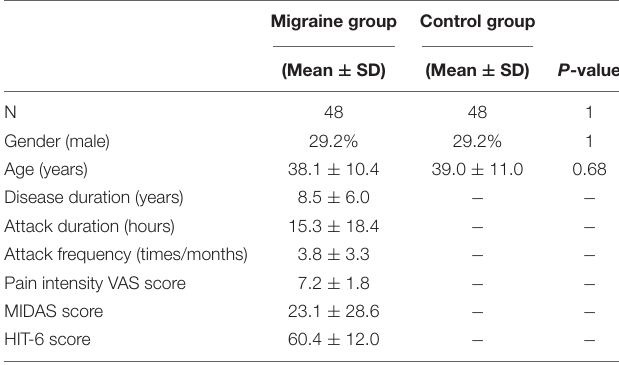
TABLE 1 | Demographic data and clinical scores of the MWoA group and control